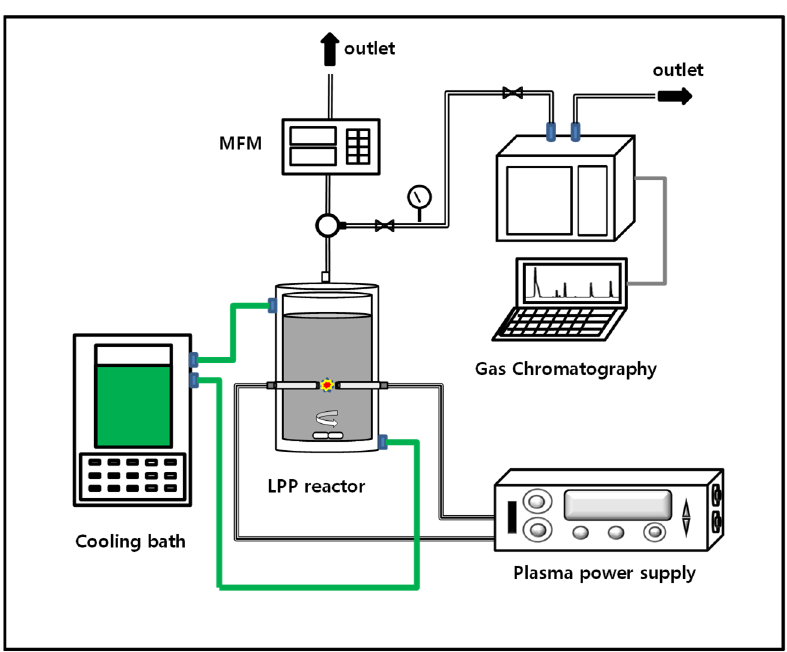
Figure 8. Schematic diagram of a photocatalytic reaction device using the LPP